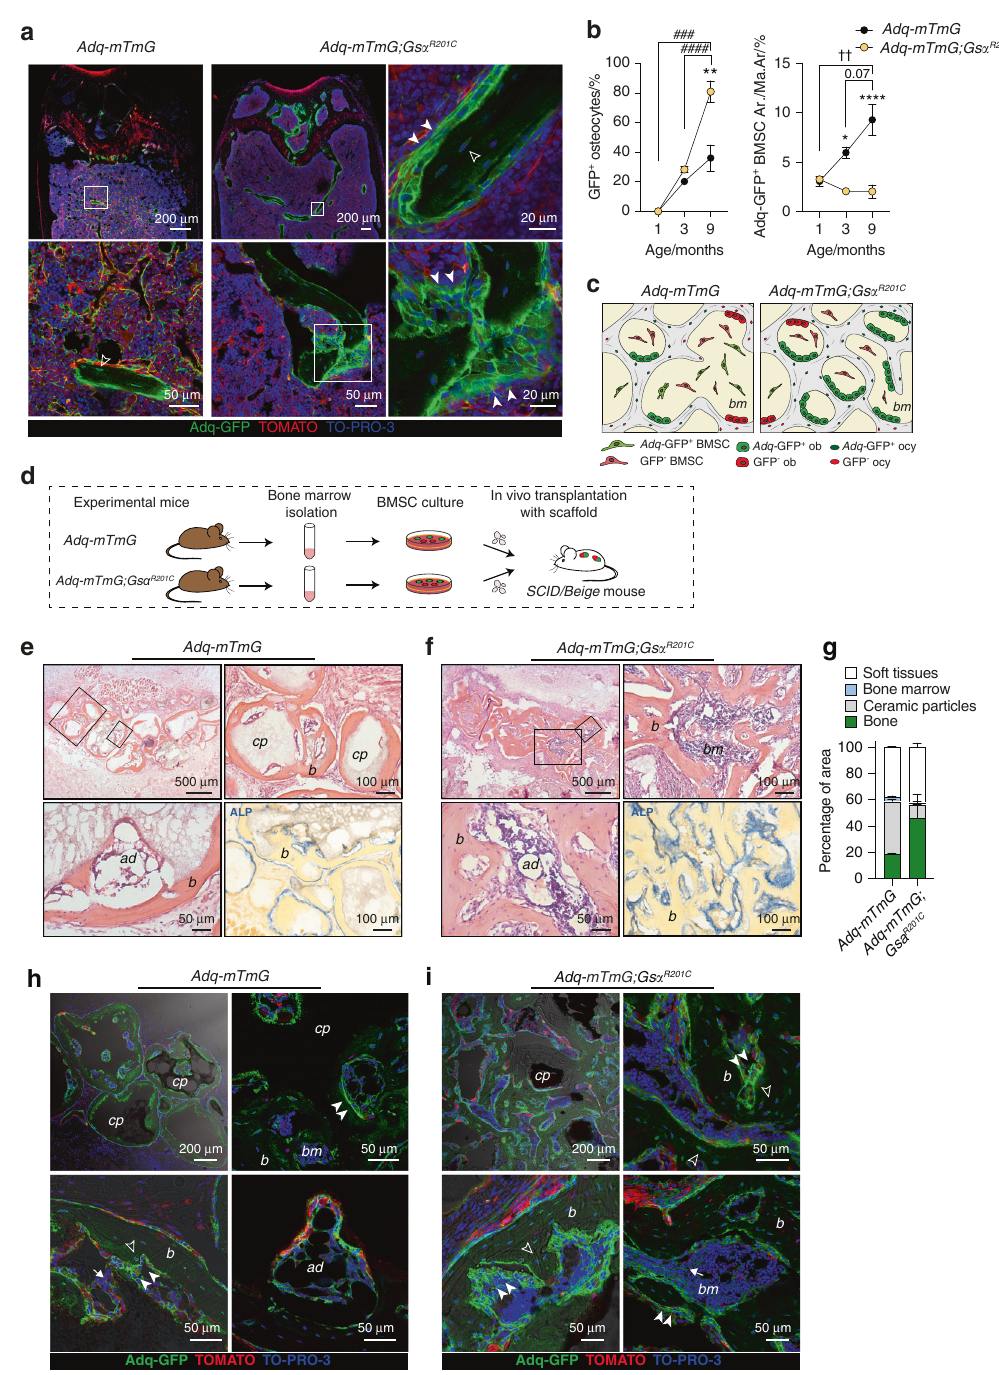
Fig. 4 Osteogenic activity of Adq- marrow stromal cells in situ and in heterotopic transplants. a Representative images of trabecular bone from 9-month-old Adq-mTmG and Adq-mTmG ; Gs α R201C mice showing GFP-marked osteoblasts ( arrowhead ) and osteocytes ( hollow arrowhead ). b Quanti fi cation of the fraction of GFP-labeled osteocytes and the GFP-labeled stromal cells area in Adq-mTmG and Adq-mTmG ; Gs α R201C mice at different ages. Statistical analysis performed using Two-way ANOVA followed by Sidak ’ s multiple comparison test. * P < 0.05, ** P < 0.01, **** P < 0.000 1 for comparison between Adq-mTmG and Adq-mTmG ; Gs α R201C mice. ### P < 0.001, #### P < 0.000 1 for comparison of different ages in Adq-mTmG ; Gs α R201C mice. †† P < 0.01, for comparison of different ages in Adq-mTmG mice. The exact P -value was reported for the comparison between 3 and 9 months in Adq-mTmG mice. c Scheme of changes in the trabecular bone mass and GFP-labeled osteoblasts, osteocytes and stromal cells in Adq-mTmG and Adq-mTmG ; Gs α R201C mice. d Experimental design for the heterotopic transplantation of BMSCs in SCID/beige mice. e , f H&E-stained section of transplants made with BMSCs derived from Adq-mTmG ( e ) and Adq-mTmG;Gs α R201C ( f ) mice, showing newly generated bone ( b ), bone marrow ( bm ) and adipocytes ( ad ). Carrier particles ( cp ) were easily recognized only in Adq-mTmG samples. Numerous ALP positive stromal cells were detected in transplants generated with cells from Adq-mTmG;Gs α R201C mice. g Quanti fi cation of fraction of transplant area occupied by soft tissue, bone marrow, ceramic particles and bone. h , i Representative confocal images of the same transplants showing GFP labeling in the majority of osteoblasts ( arrowhead ) and osteocytes ( hollow arrowhead ), in adipocytes ( ad ) and in stromal cells ( arrow